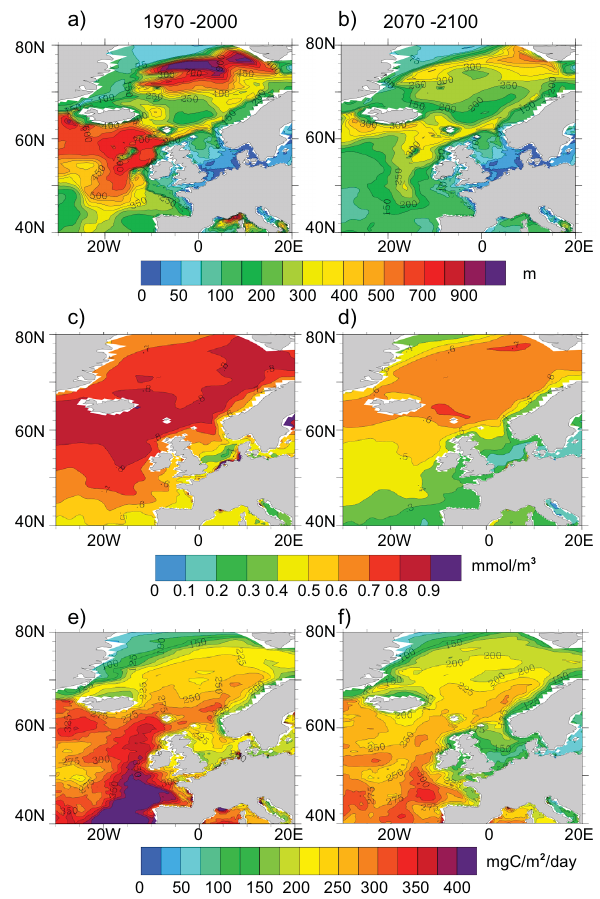
Fig. 8. (a) and (b) average winter (DJF) mixed layer depth at the end of the 20th and 21st centuries. (c) and (d) same as (a) and (b) but for average dissolved surface phosphate concentration. (e) and (f) same as (a) and (b) but for vertically integrated yearly mean primary